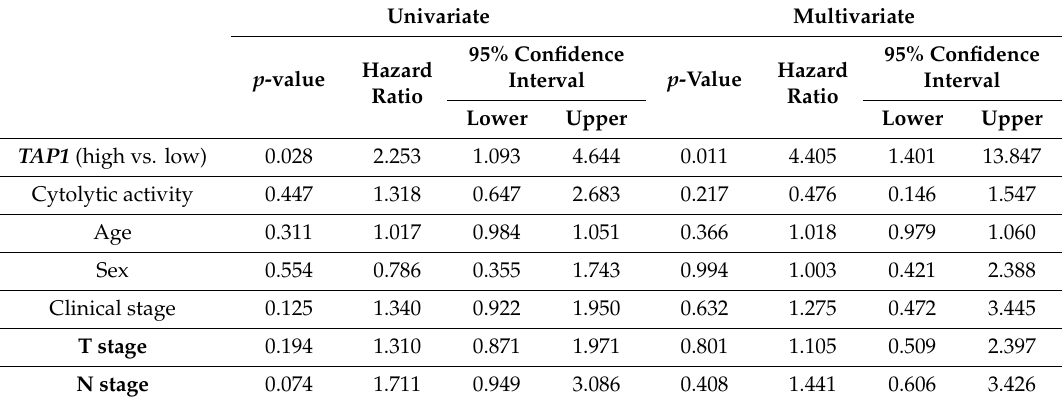
Figure 4. The influence of TAP1 levels in tumor-free samples from the TCGA-HNSC cohort on patient survival. Kaplan–Meier curves of overall survival for ( A ) tumor-free samples (denominated “normal” by TCGA), ( B ) matched tumor samples, and ( C ) all SCCHN tumors available in the TCGA database. Blue lines represent patients with low TAP1 levels, and red lines indicate patients with high TAP1 levels. N = number of samples Table 5. Survival analysis with Cox regression on tumor-free samples in the TCGA HNSC